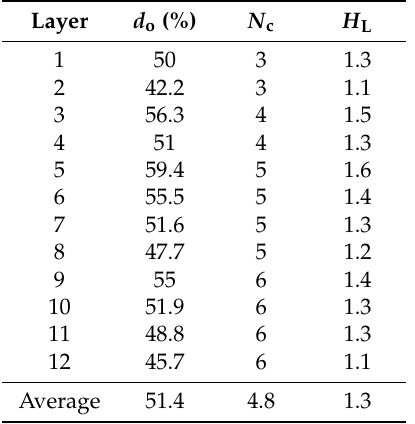
Table 2. Parameters of each layer and average value. Overlap percentage ( d o ), number of clads per layer ( N c ) and layer height predicted by the model ( H L ).